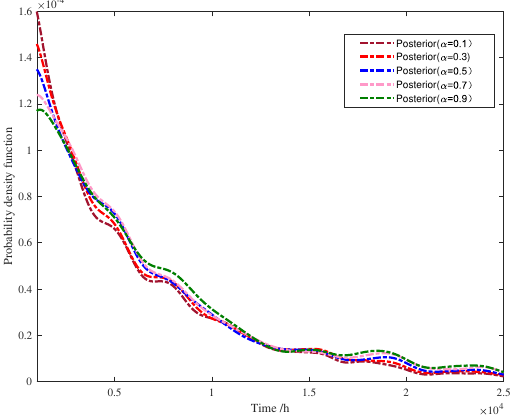
Figure 5. The posterior of the probability density function by different weights.